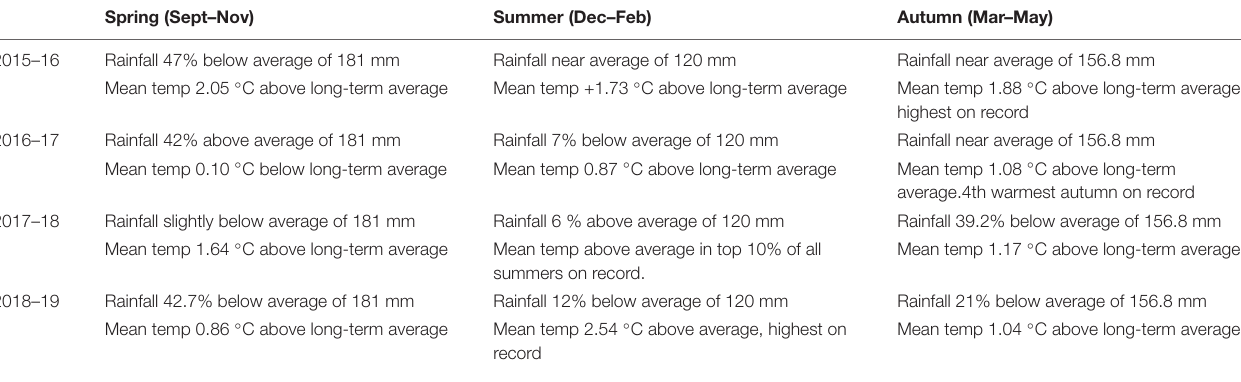
TABLE 1 | Victorian climate descriptions for the four seasons of the study from the Bureau of